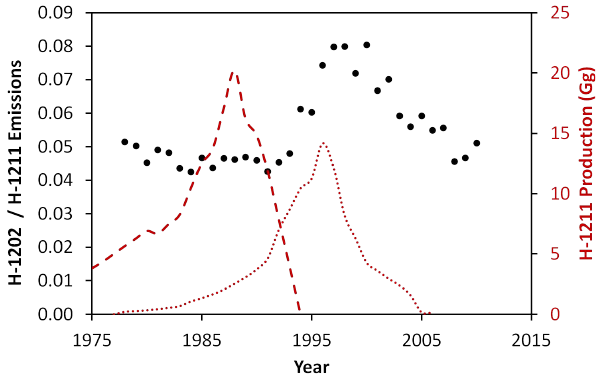
Fig. 4. The ratio of model-derived emissions of H-1202 to H-1211 (see Fig. 2) (black circles). Also shown is production of H-1211 in non-Article 5 countries (red dashed line) and Article 5 countries (red dotted line) (HTOC,